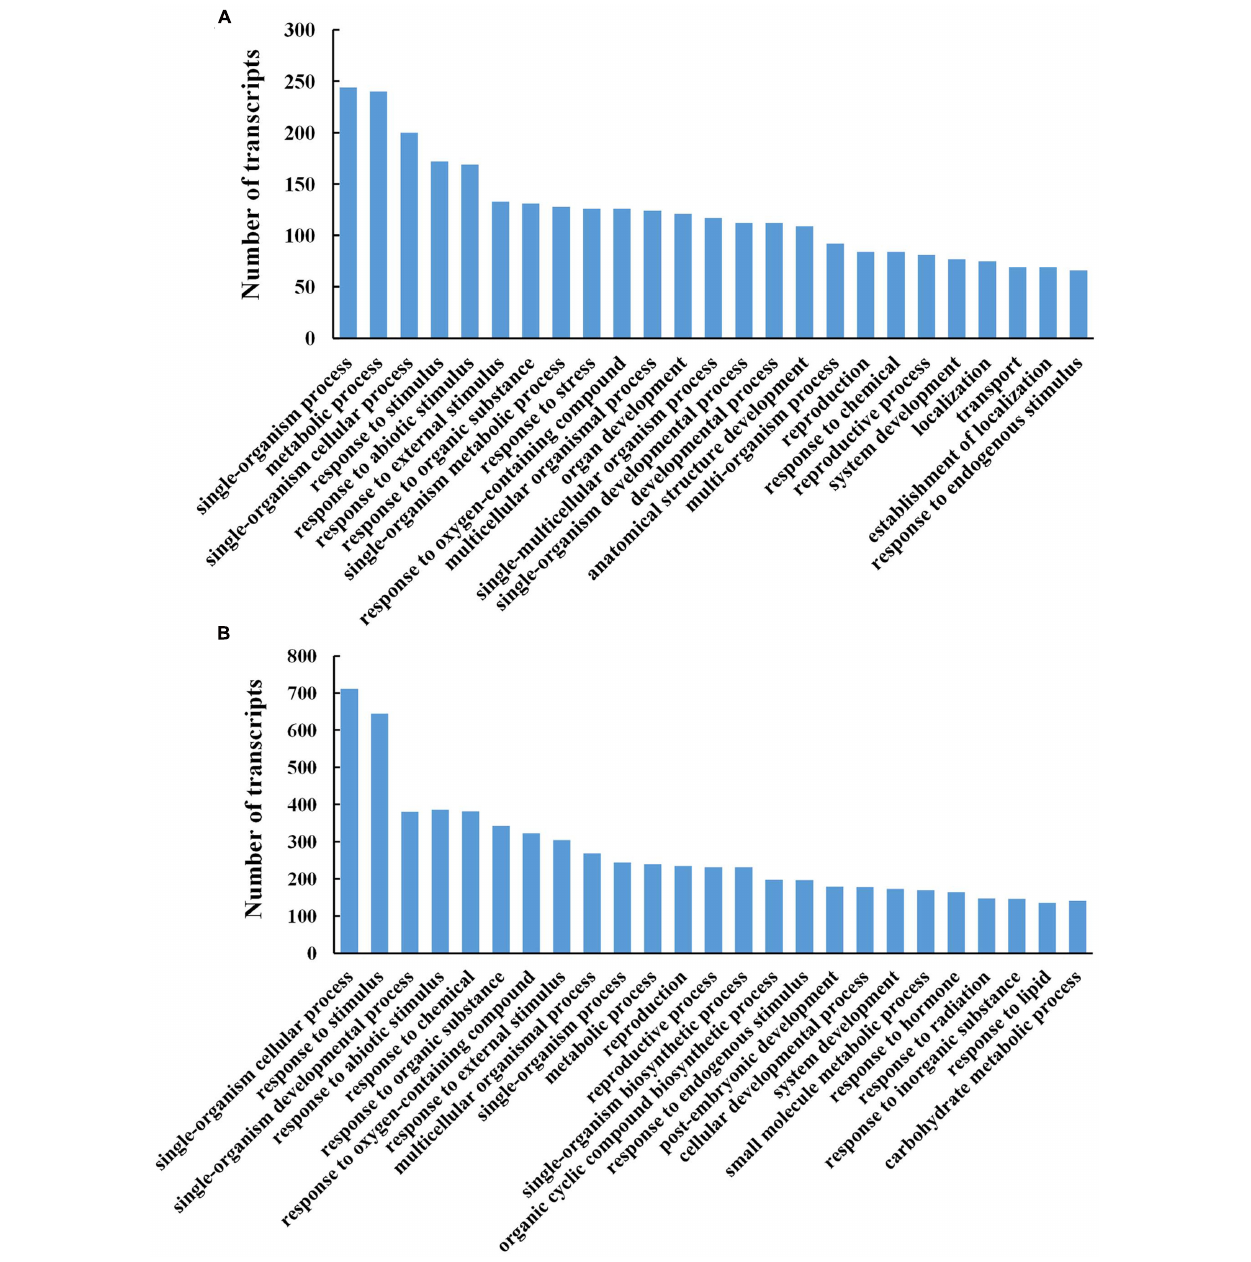
FIGURE 4 | Gene ontology functional classification analysis of differentially transcribed genes (DTGs) during petal abscission. Histograms representing functional distributions (GO biological process class) of DTGs obtained from stage 3 compared to stage 1 (A) , and from stage 5 compared to stage 3 (B) . DTGs were determined using a cutoff ratio of > 2 or < 0.5 when comparing its expression in stage 3 to that in stage 1 (S3 vs. S1), and/or in stage 5 to that in stage 3 (S5 vs.